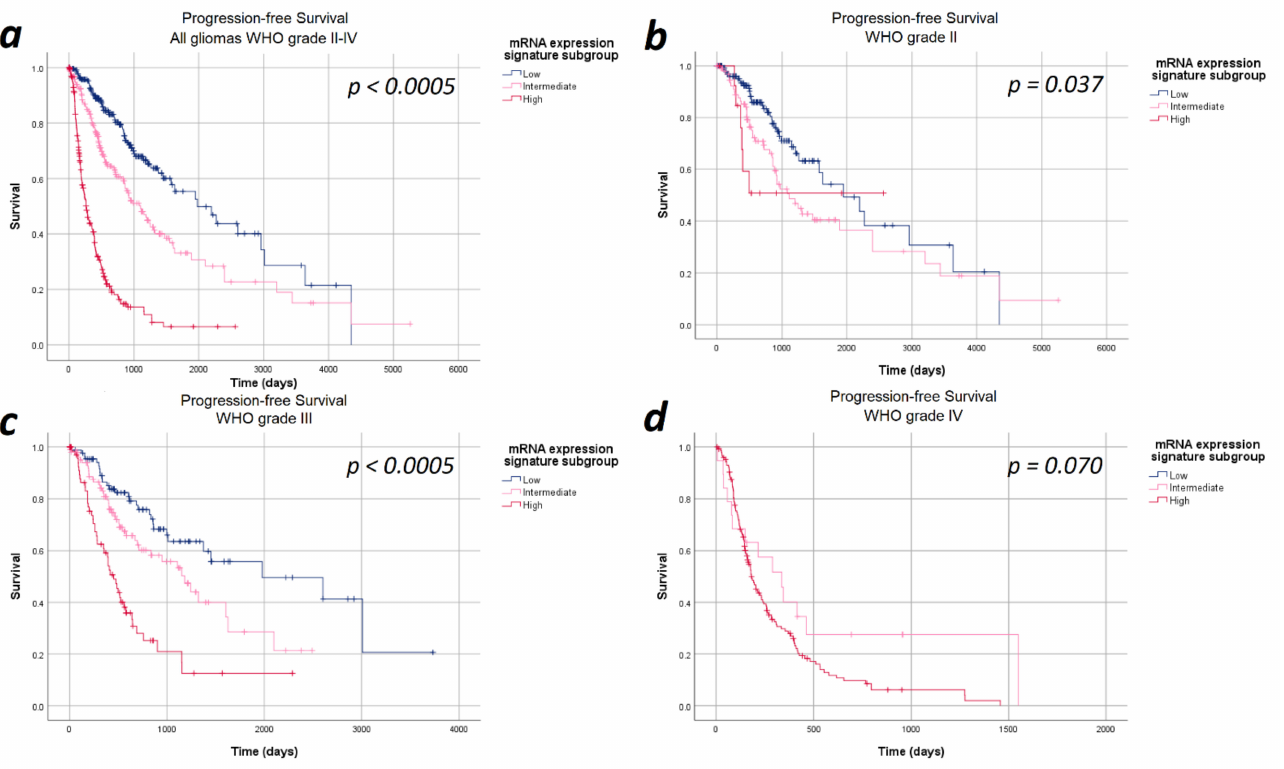
Figure 1. Kaplan–Meier curves of progression-free survival stratified by heme biosynthesis mRNA expression signature subgroups. ( a ) All gliomas WHO grade II–IV: The progression-free survival differed significantly between the mRNA expression signature subgroups in the entire study cohort. ( b ) In WHO grade II gliomas no significant differences in progression-free survival between the mRNA expression signature subgroups was present. ( c ) In WHO grade III, a significantly poorer survival was observed with increasing mRNA expression signature subgroups. ( d ) WHO grade IV gliomas: We did not find a statistically significant difference in the progression-free survival between the mRNA expression signature subgroups in WHO grade IV